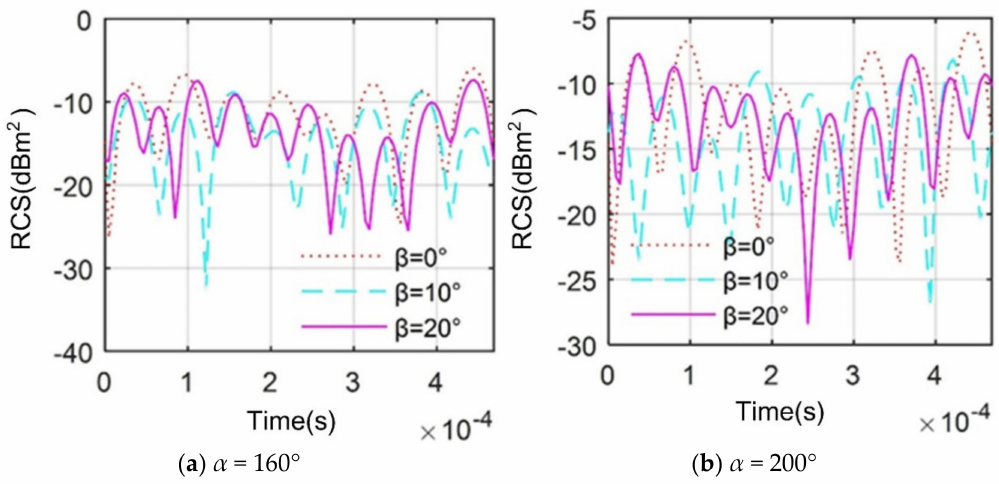
Figure 12. Influence of elevation angle on dynamic RCS of m low , N obs,low = 1 and β = (0, 10, 20) ◦ .